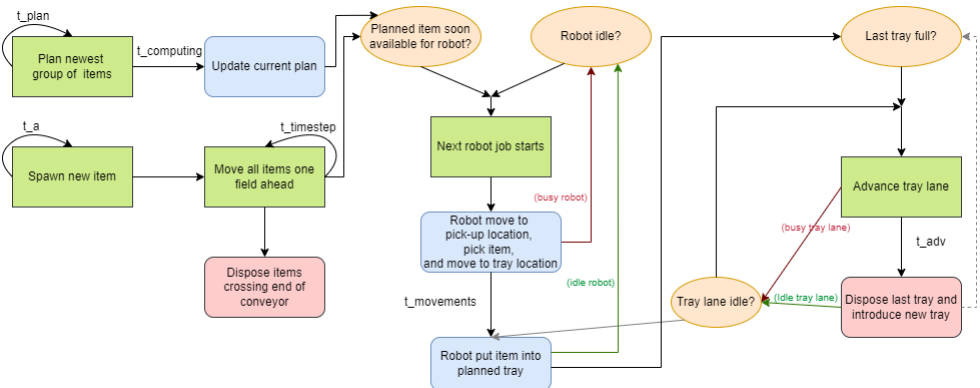
Figure 3. Simplified flow chart of the robotic batching system. t_plan is the time between planning newly arrived groups of items (deterministic), t_computing is the time to compute the plan (fixed threshold), t_a is the arrival times of items (stochastic), t_timestep is a single time step, conveyor moves all the time (deterministic), t_movements is the time that the robotic arm needs to conduct a task (deterministic), and t_adv is the time for the tray lane to advance